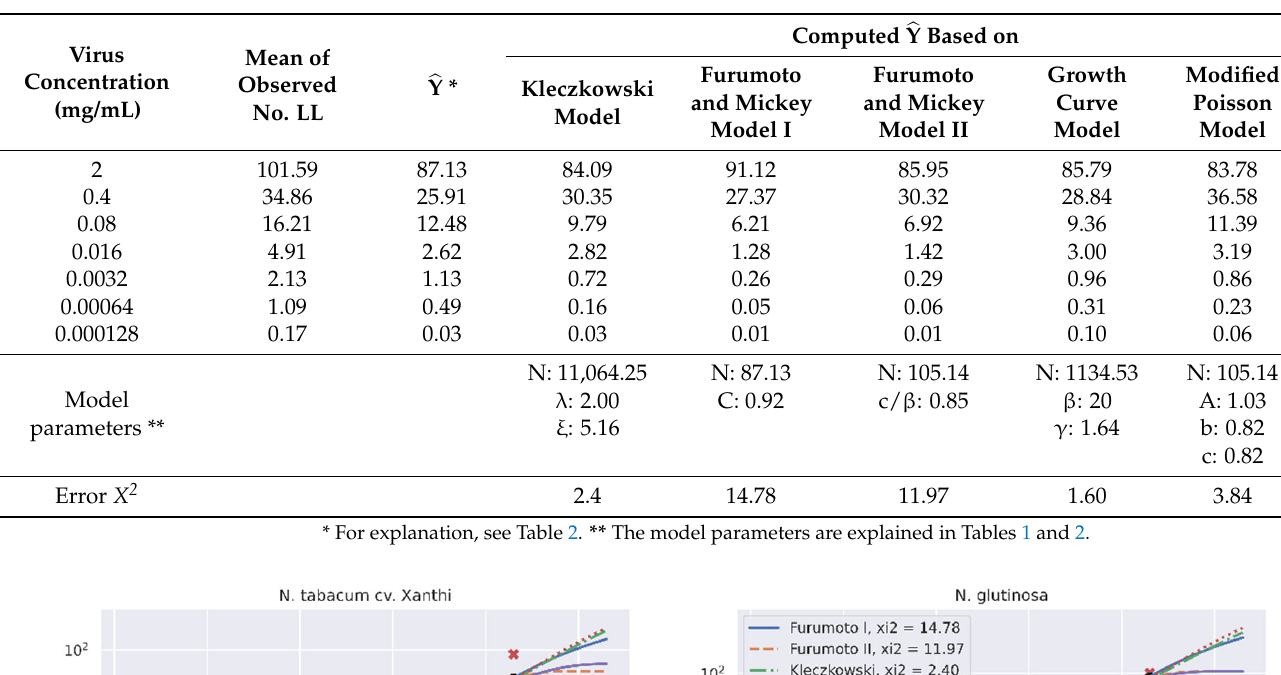
Table 3. Mean number of observed necrotic local lesions on N. glutinosa with serially diluted To- BRFV suspensions and related transformed and computed based on the different models. Data transformation performed according to Section 4.5.